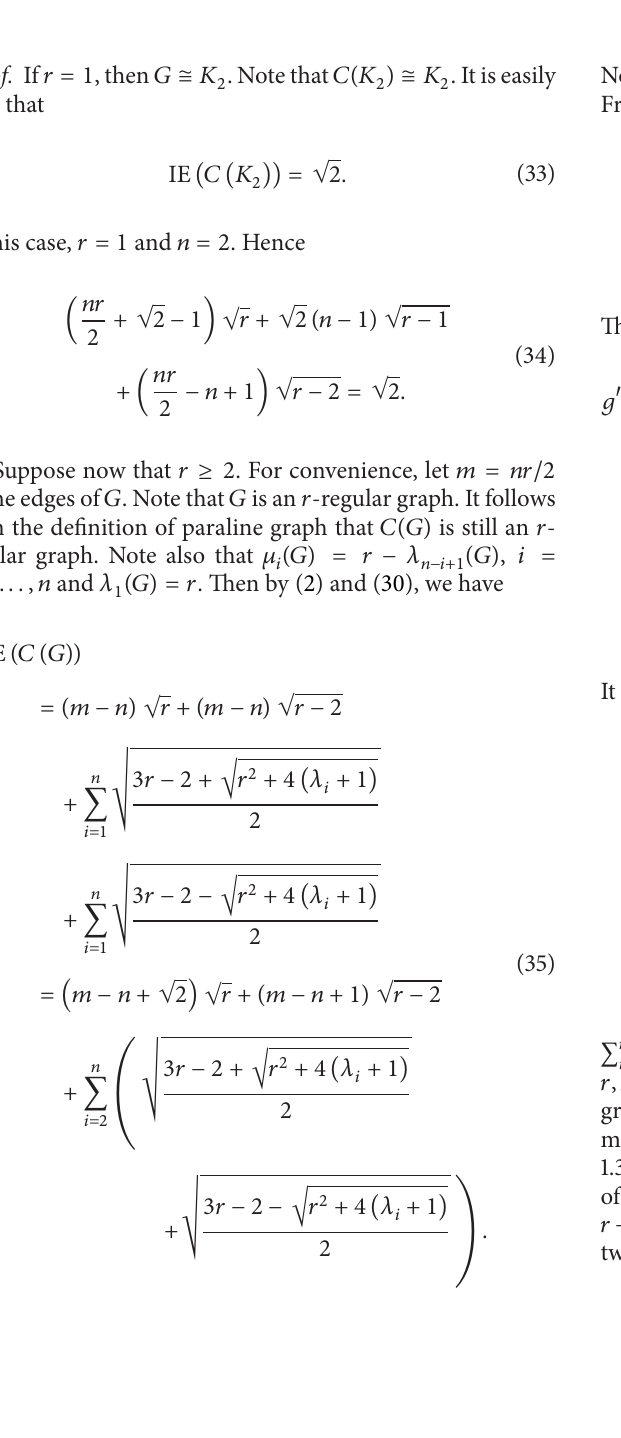
Figure 1: (a) The graph 𝐺 . (b) The graph 𝑠(𝐺) . (c) The graph 𝐶(𝐺)